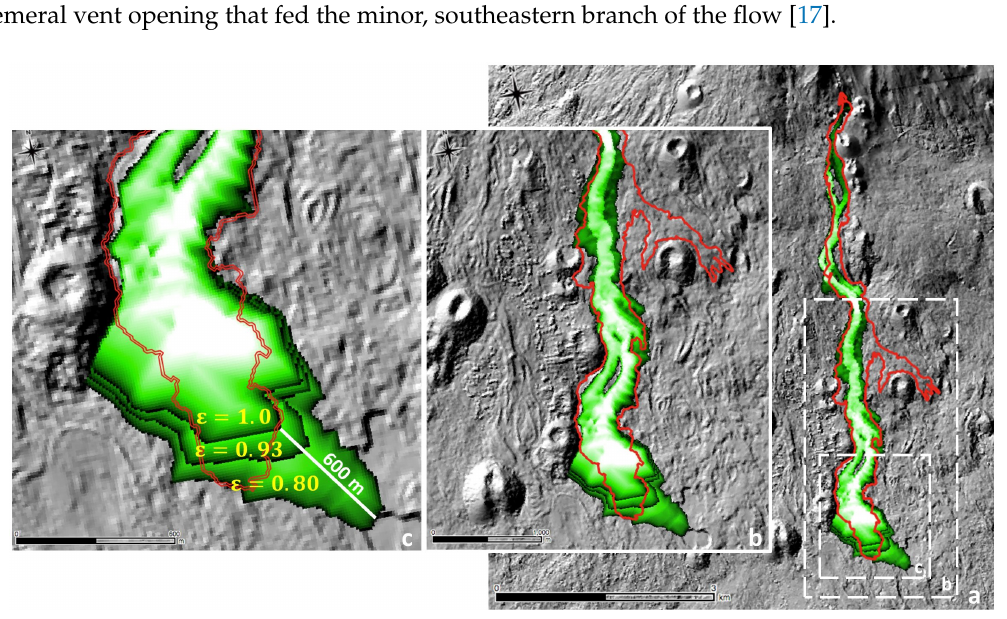
Figure 8. MAGFLOW simulation results with changing emissivity (i.e., 0.80, 0.93, and 1.00), showing a difference of up to 600 m in lava flow